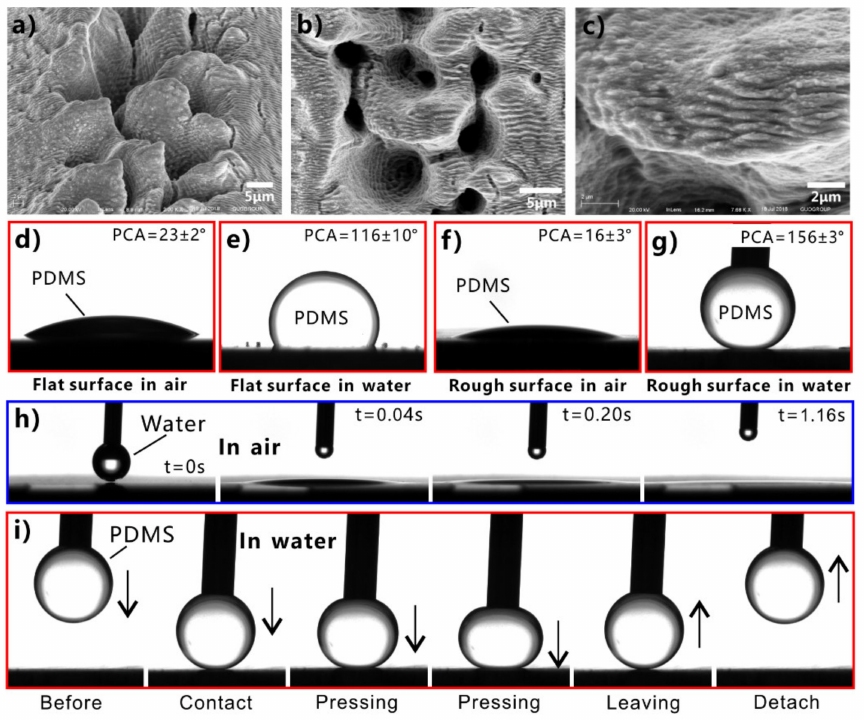
Figure 20. Underwater superpolymphobicity of the stainless steel with hierarchical surface mi- crostructures. ( a – c ) SEM images of surface microstructures on the stainless-steel surface. ( d ) A droplet of liquid polymer on the original stainless steel in air. ( e ) A droplet of liquid polymer on the original stainless steel in water. ( f ) A droplet of liquid polymer on the structured stainless-steel surface in air. ( g ) A droplet of liquid polymer on the structured stainless-steel surface in water. ( h ) A water droplet wetting the structured surface. ( i ) Moving an underwater liquid polymer droplet to contact and then leave the structured stainless-steel surface. Reprinted from ref.